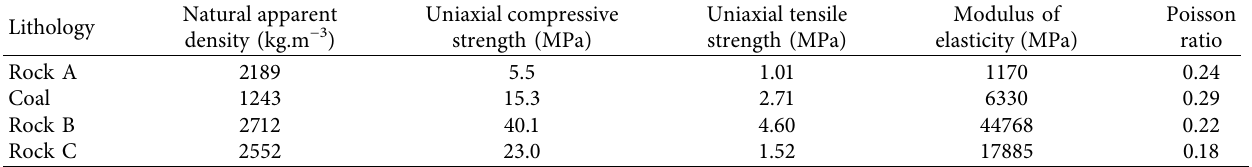
Table 1: Physical mechanical parameter characters of coal and rock in one coal mine.